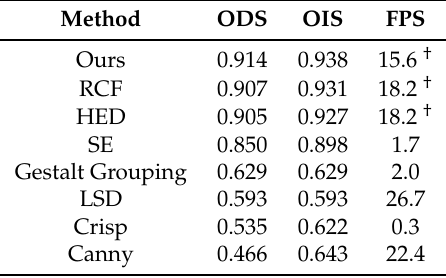
Table 3. The quantitative comparison with baselines on PLDU dataset, † means GPU